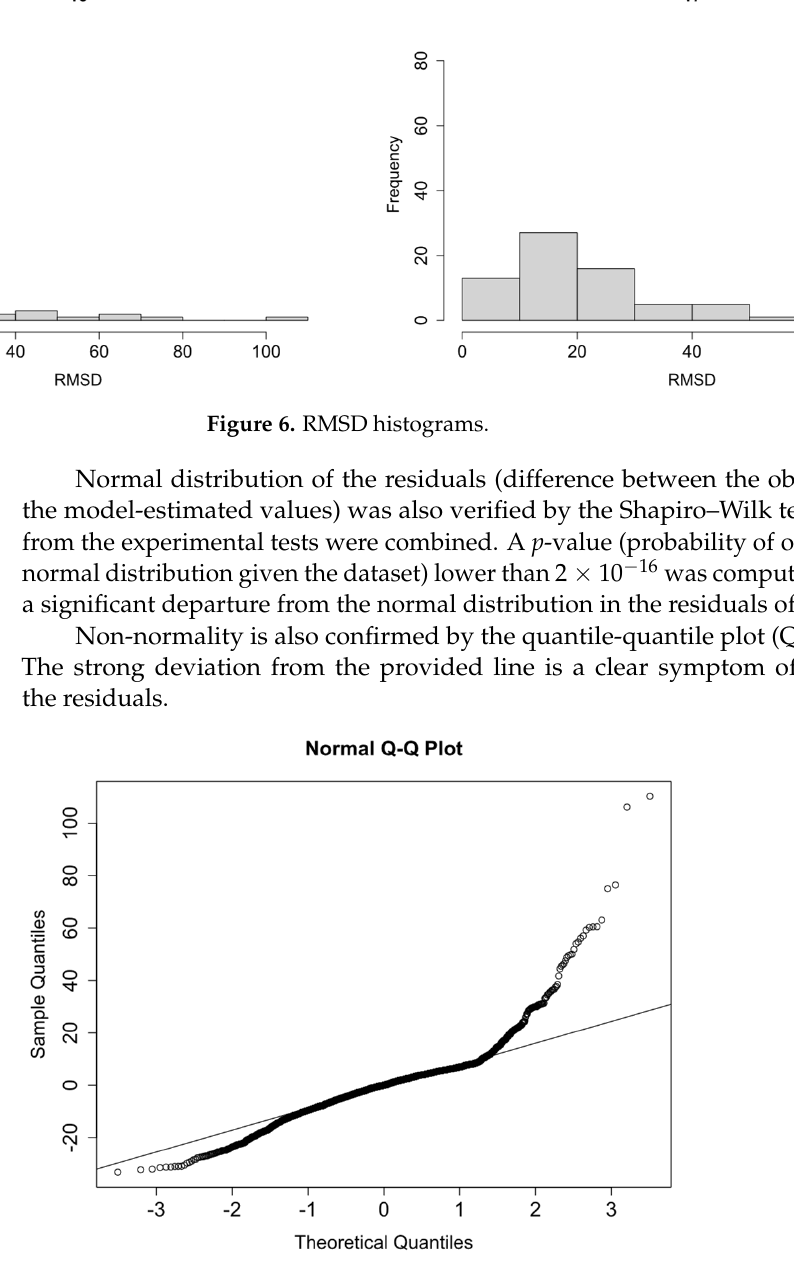
Table 2. Kolmogorov-Smirnov test.